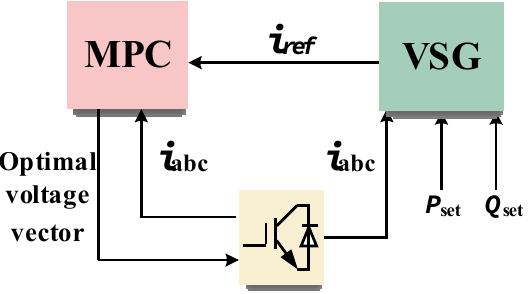
Figure 4. Connection between virtual synchronous generator and model predictive control.